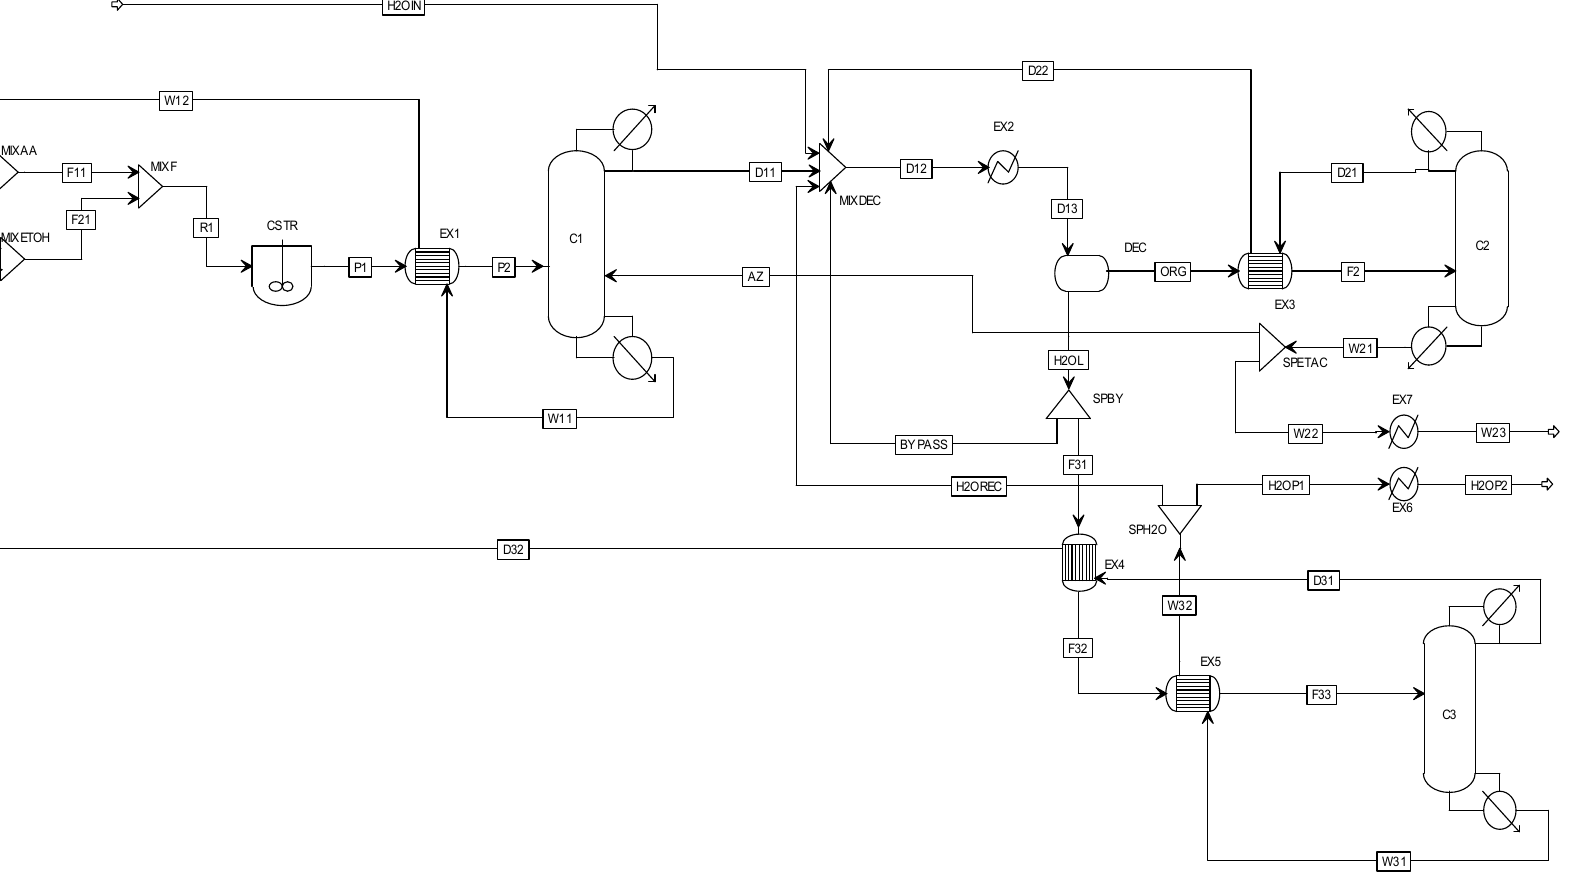
Figure 1. Ethyl acetate production via conventional process set-up.